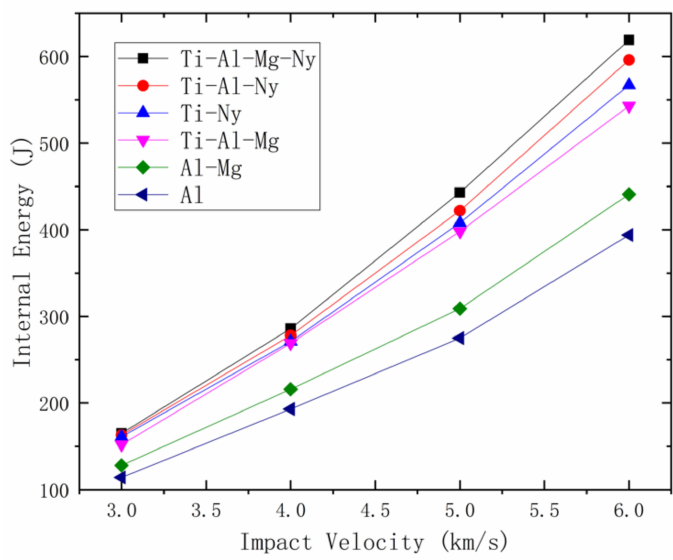
Figure 7. Internal-energy transformation under different impact